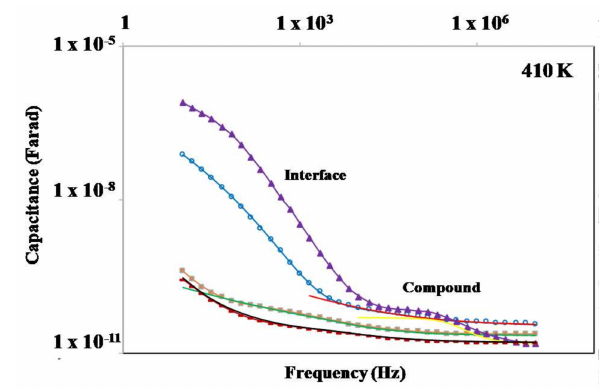
Figure 9. Representation of capacitance C (cid:48) vs. f for the studied salts.